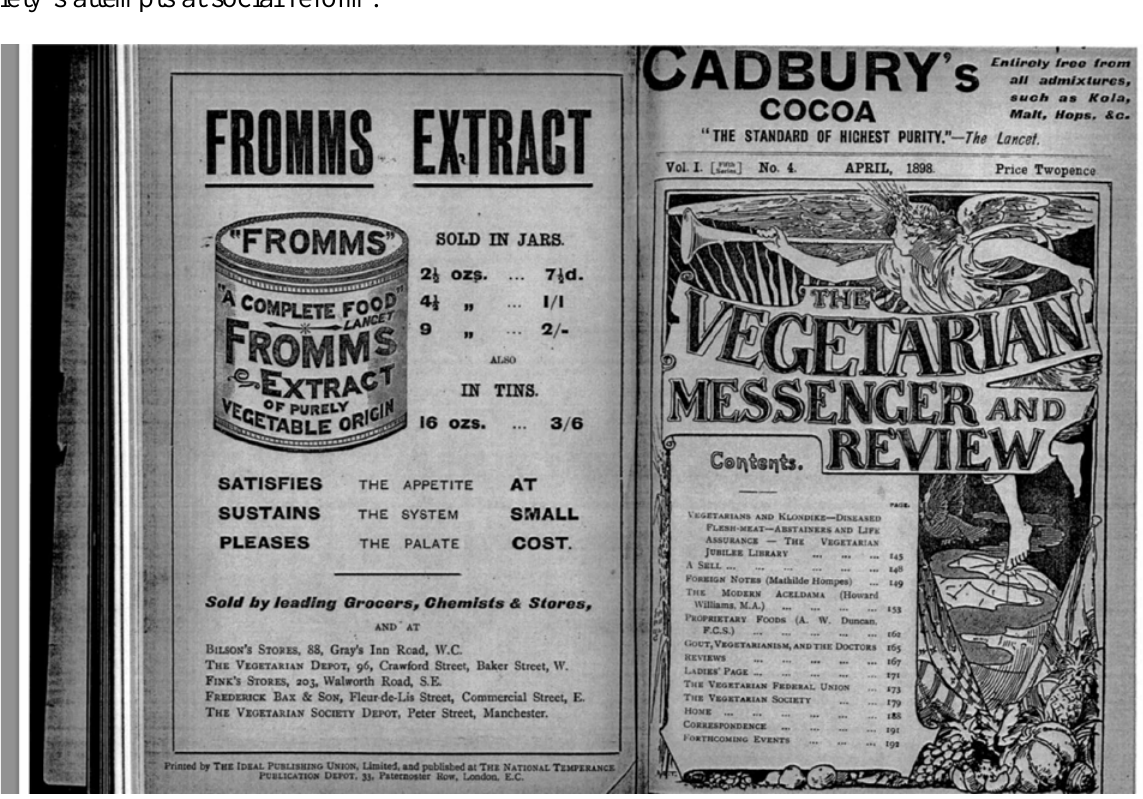
Figure 1. The front and back cover of the Vegetarian Messenger from April 1898 reveals the commercialization of